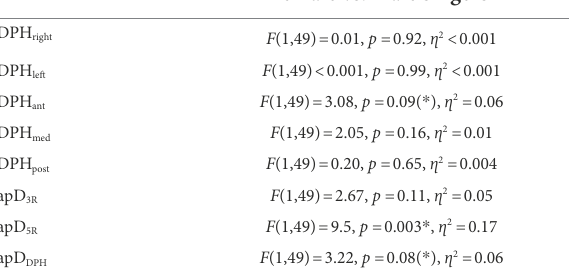
TABLE 5 Differences between male and female subjects’ phonatory movement range in relation to the respiratory movement range (ROM p/r ), separately analyzed for each